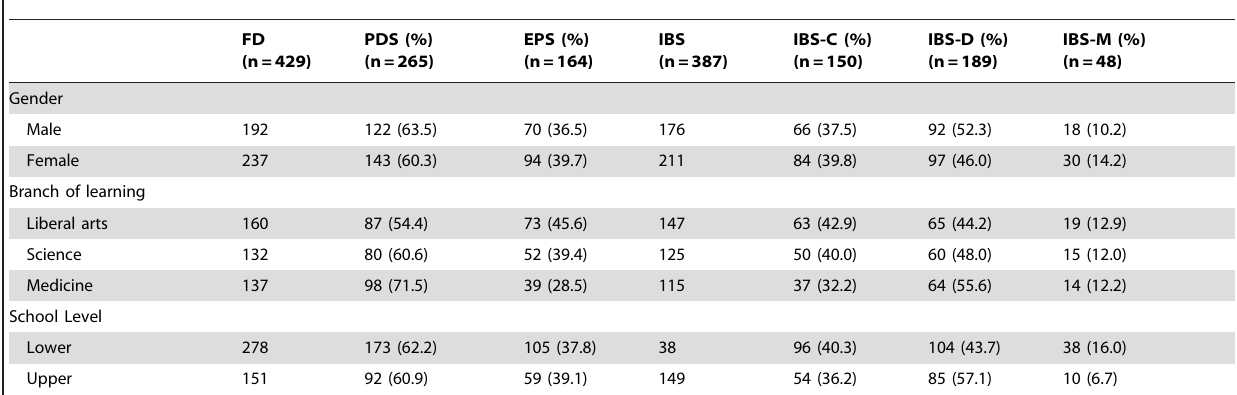
Table 2. Characteristics of students with functional dyspepsia and irritable bowel syndrome subtypes.